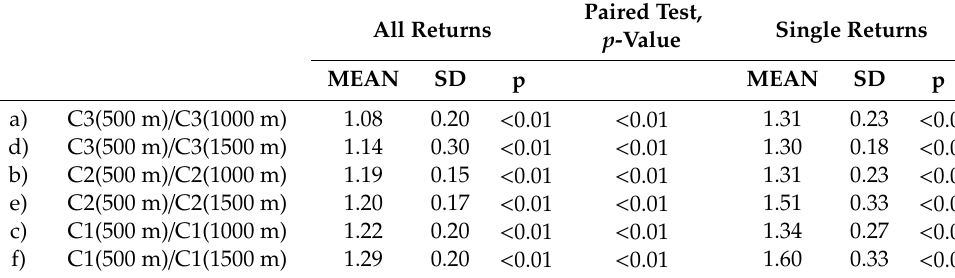
Two sample Mann-Whitney test p -values are given for 0.95 confidence